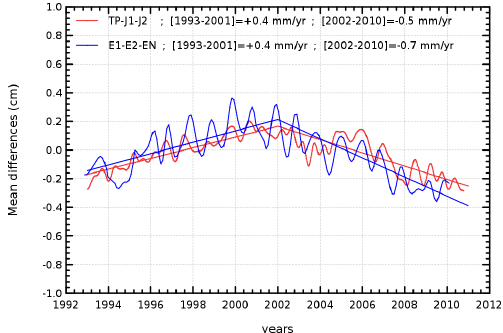
Figure 4. Temporal evolution of global mean differences between altimeter SSHs corrected from wet troposphere corrections computed with ERA-Interim and the radiometers (in cm). Statistics are computed with TOPEX/Jason-1/Jason-2 data (in red) and ERS-1/ERS-2/Envisat data (in blue) without any geographical selection. The drifts between ERA-Interim and radiometer WTC have been computed by decades (1993–2001 and 2002–2010) for both time series and are indicated at the top.